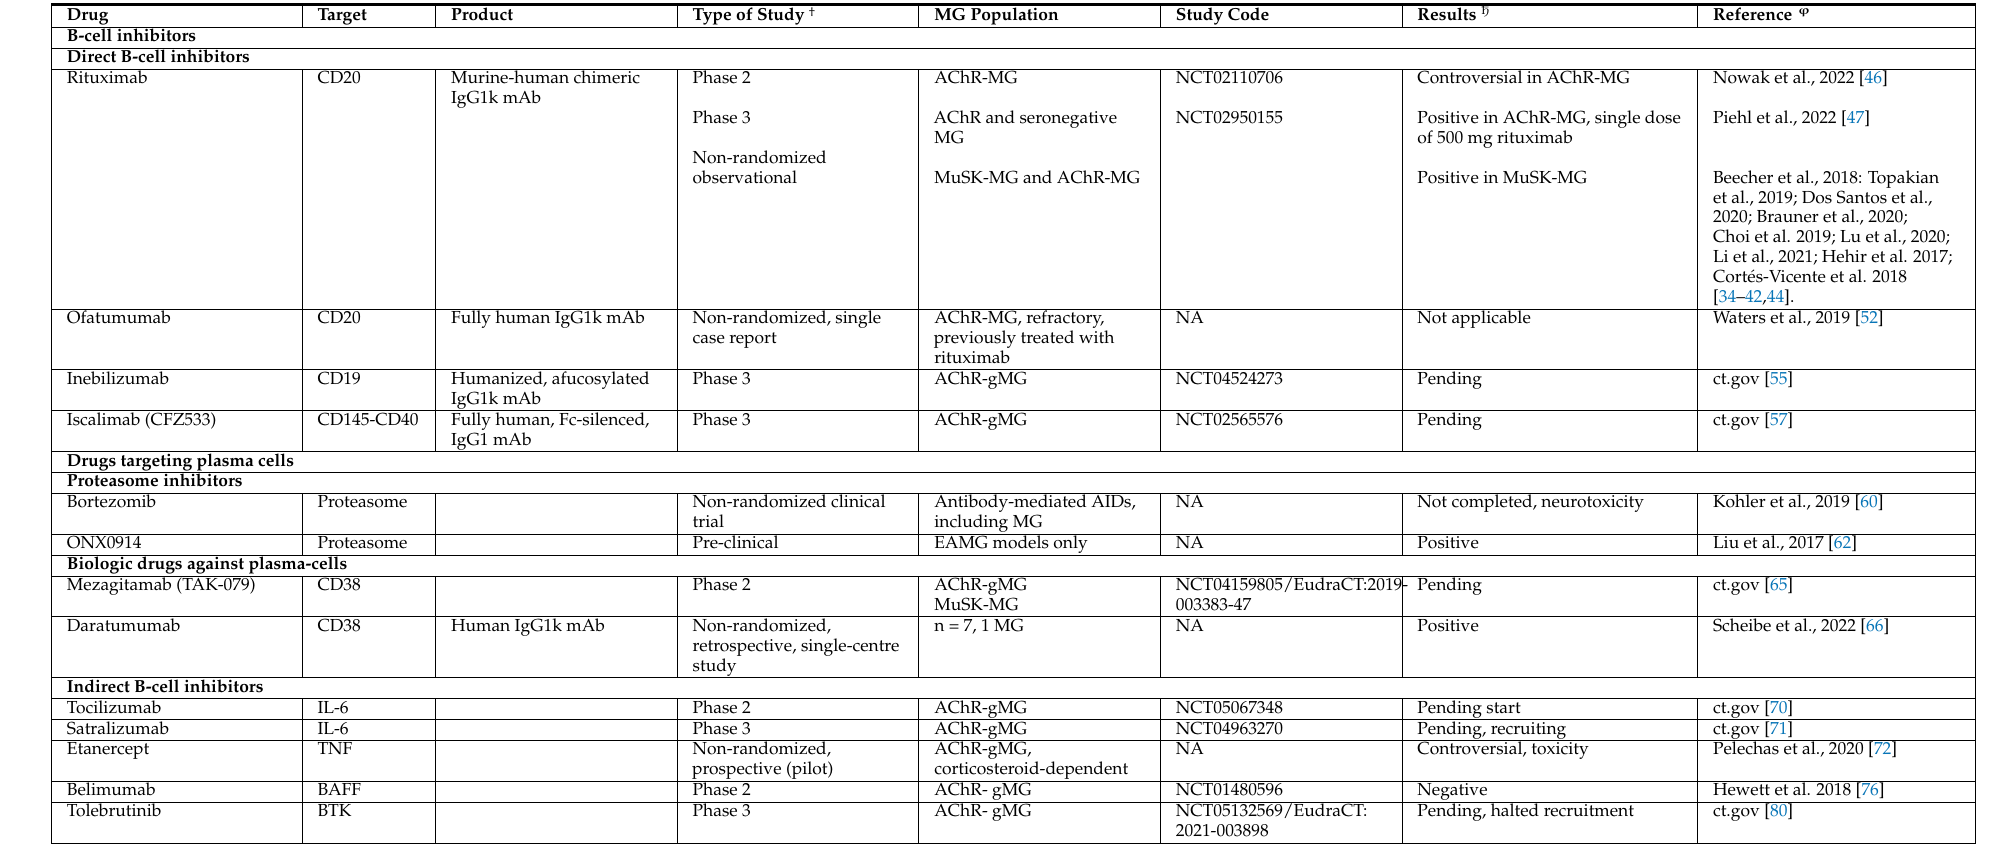
Table 1. Main targeted drugs in myasthenia